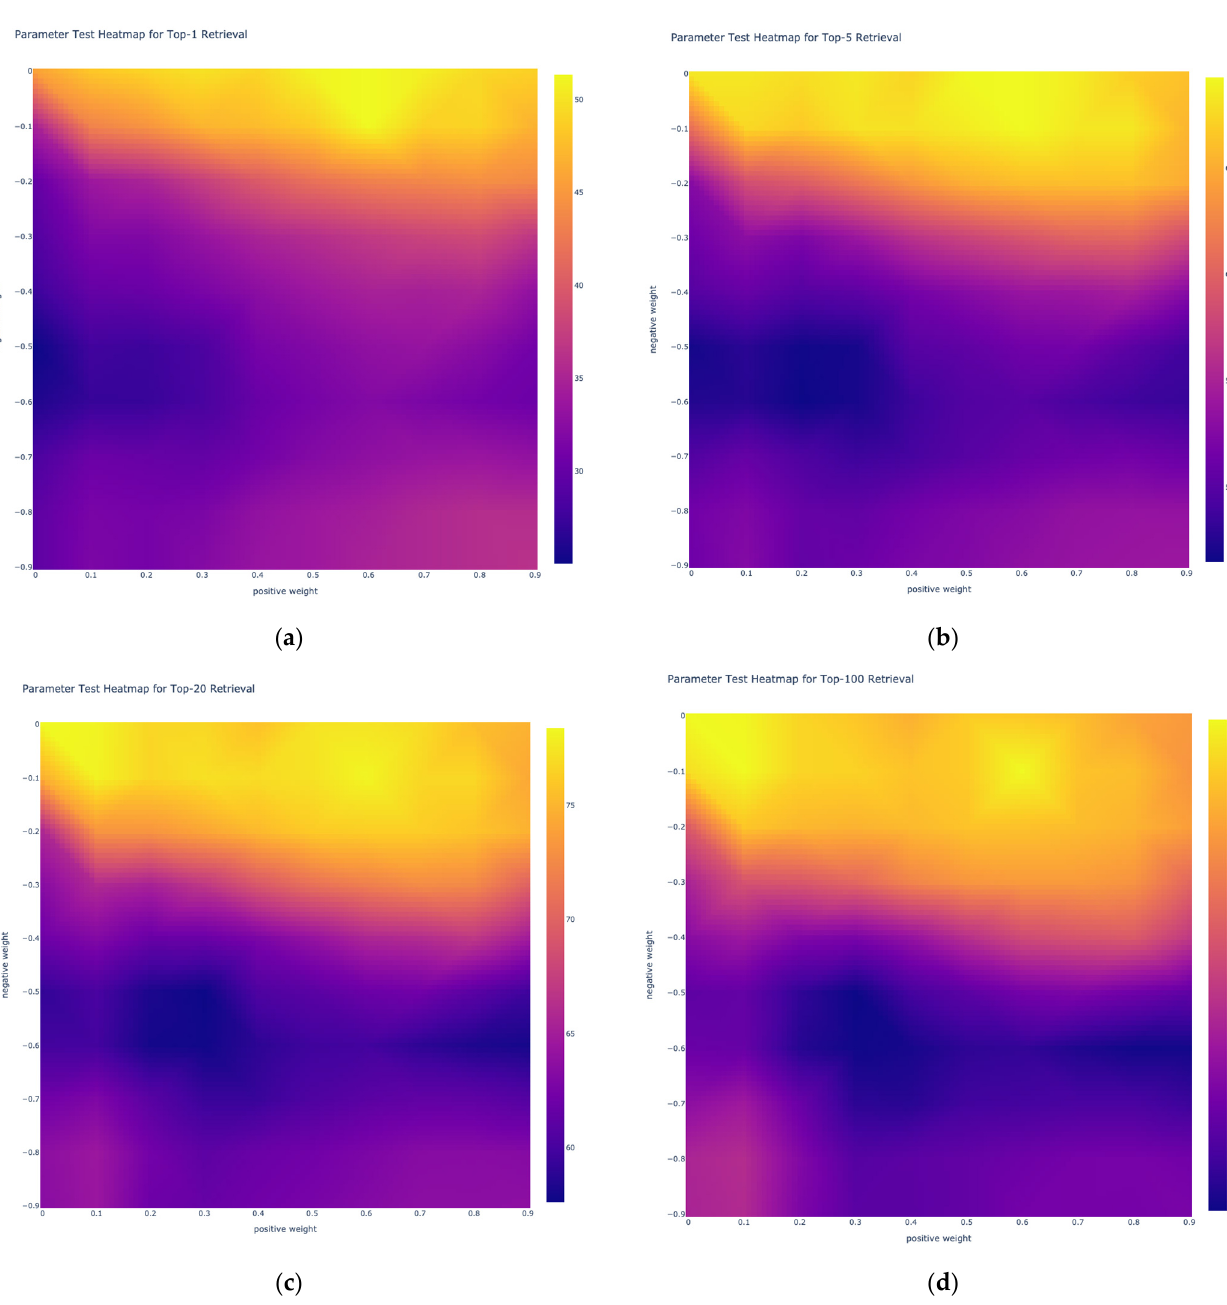
Figure 6. These are weight combinations experimental results (on NQ dataset) heat map, whose x-axis denotes relevant query representations’ weight β and y-axis denotes irrelevant query representations’ weight γ . The retrieval performance (EM) results are as follows: ( a ) Top-1; ( b ) Top-5; ( c ) Top-20; ( d ) Top-100.